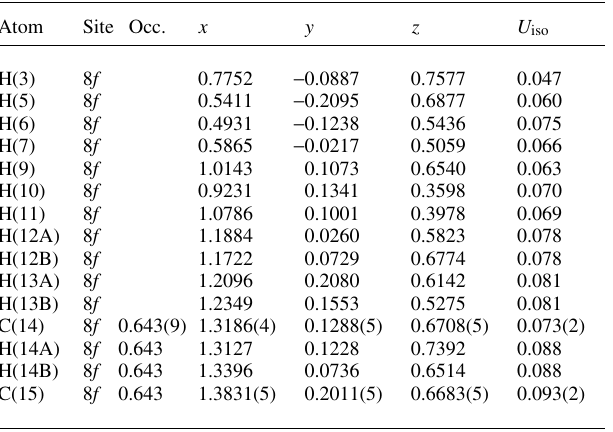
Table 2. Atomic coordinates and displacement parameters (in Å 2 )